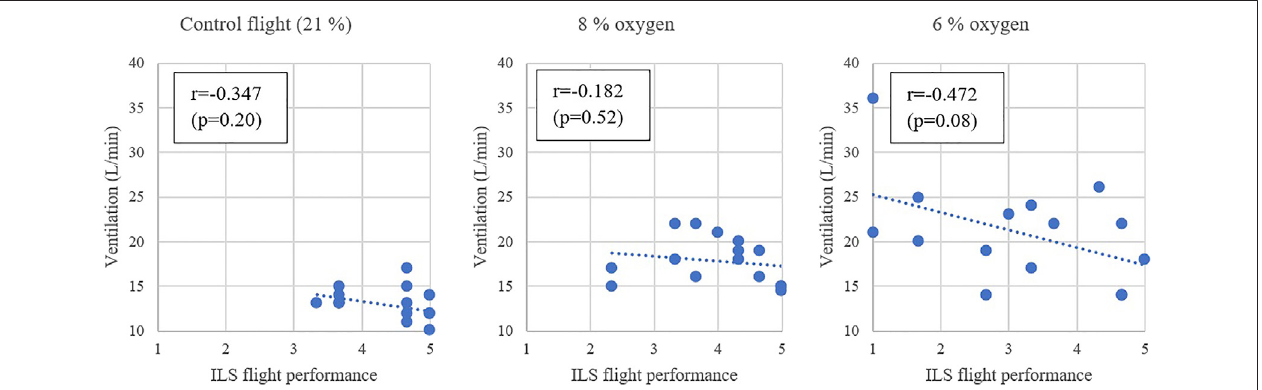
FIGURE 5 | The minute ventilation during the exposure gas and the ILS fl ight performance during the RTB.